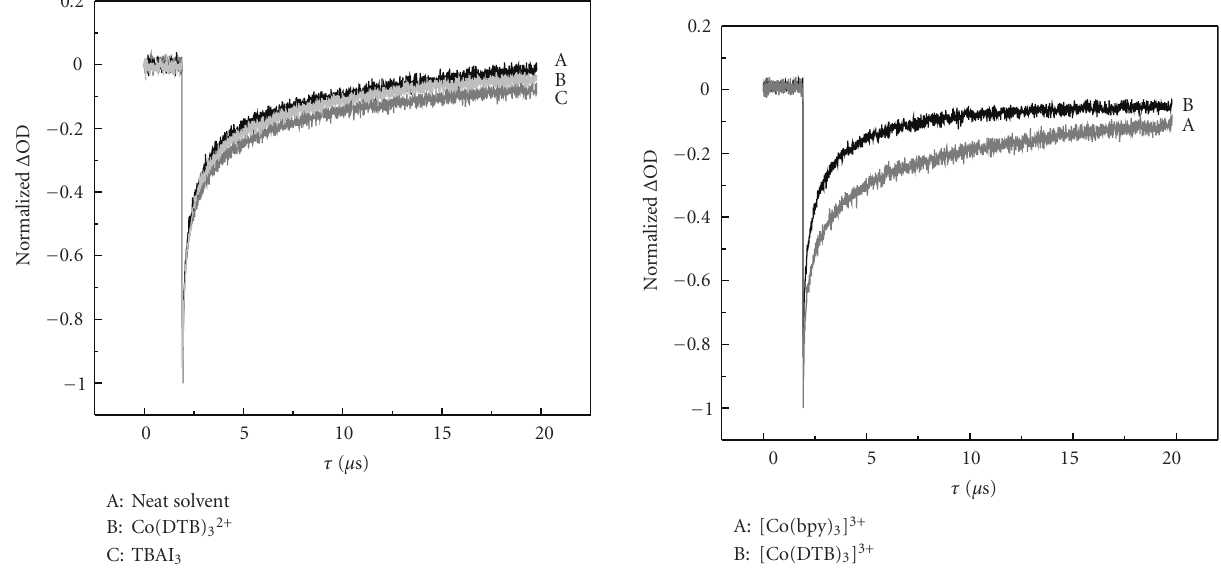
Figure 11: 480nm Ru(III)(H 2 DCB) 2 (NCS) + Tetrabutyl-ammonium triiodide (B); (b) Co(DTB) 3+